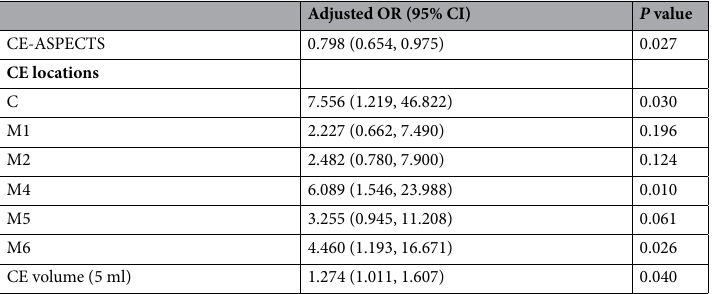
Table 3. Multivariable logistic regression analysis of predictors for poor outcome. Adjusted for age, initial NIHSS, the procedure time, passes of retriever and mTICI 2b-3. CE contrast enhancement, ASPECTS Alberta stroke program early computed tomography score, C caudate nucleus, 95% CI indicates 95% confidence interval, OR odds ratio.